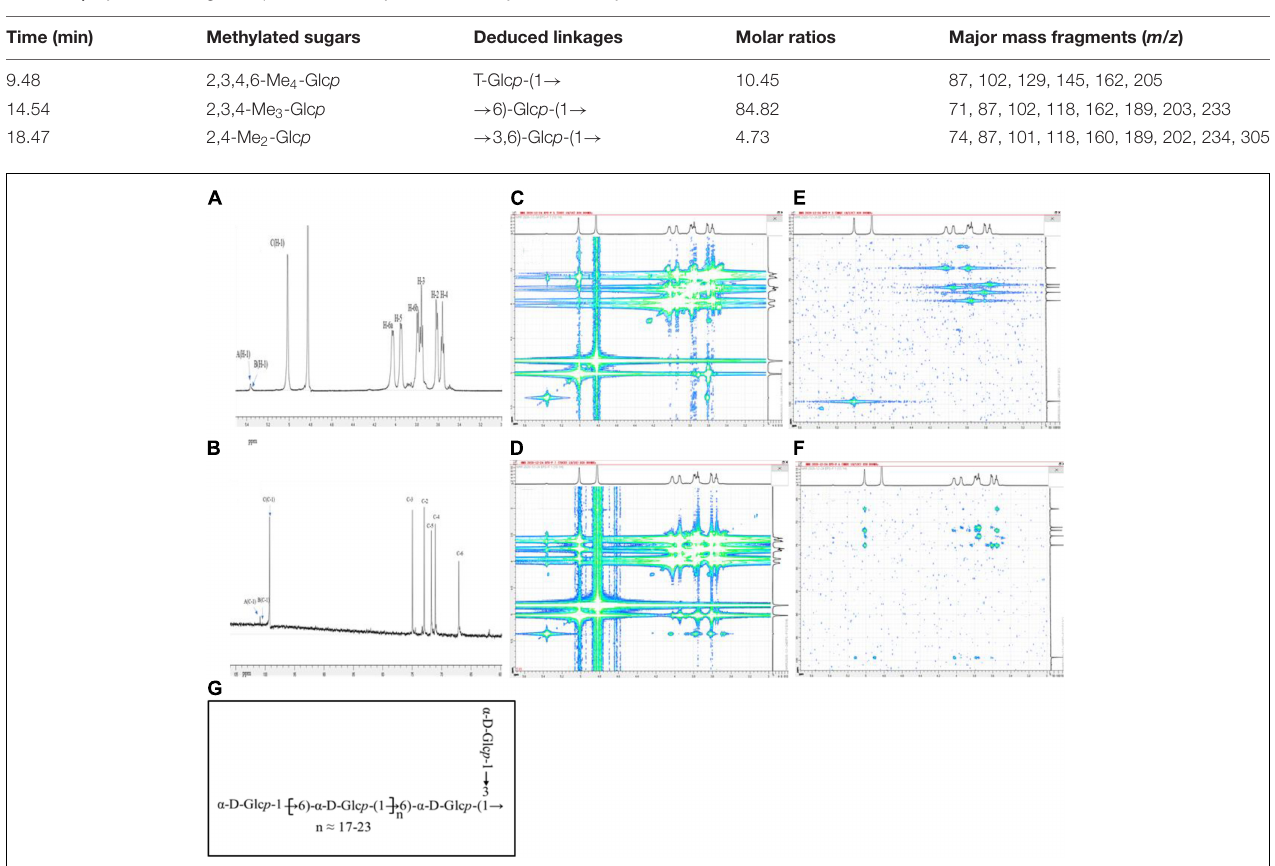
TABLE 2 | Glycosidic linkage composition of methylated EPS-F2 by GC–MS analysis.